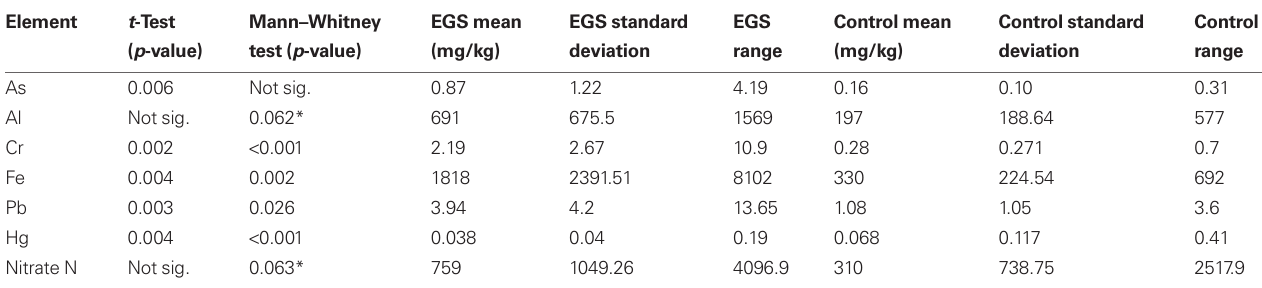
Table 3 | Herbage significant differences between EGS and control sites. Significance (95% confidence level / p < 0.05)/near significance between EGS and control herbage samples were found for the following analyses of element